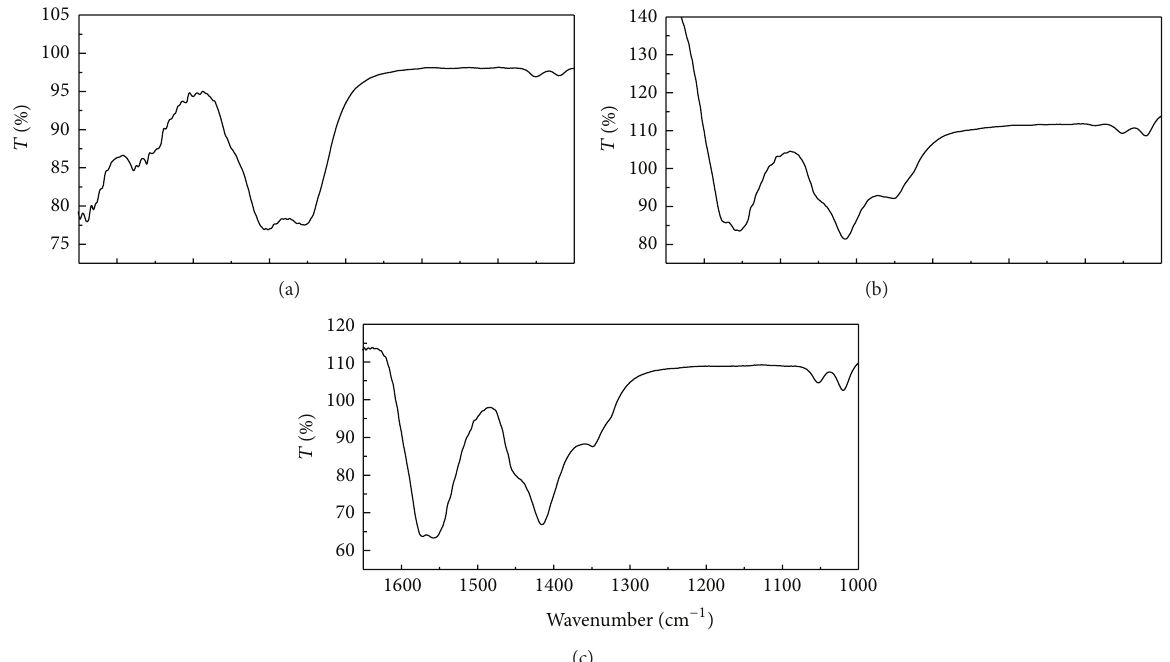
Figure 3: FTIR spectra for cerium ( ΙΙΙ )-acetate complex in the range of 1000–1650 cm −1 and molar ratio of cerium and acetate (a) 1:1; (b) 1:6; (c) 1: